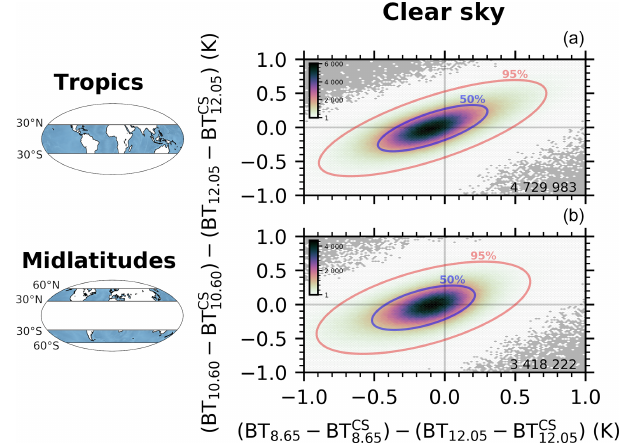
Figure 2. Clear-sky IIR signature (Sect. 3) observations over ocean during the 2008–2019 period shown as the difference between the 10.60 and 12.05µm channels ( y axis) as a function of the difference between the 8.65 and 12.05µm channels ( x axis). Panels (a) and (b) show the tropics (30 ◦ S–30 ◦ N) and the midlatitudes (30–60 ◦ ) regions. The 5km atmospheric columns are considered as clear-sky column when they do not contain any feature detected with hori- zontal averaging less than 80km (so no single-shot cleared cloud either). The color map of each 2-D distribution linearly increases from one (white) to the maximum (black) of each subplot; no oc- currence appears gray. The red and blue ellipses represent the 95% and 50% confidence intervals of the 2-D Gaussian PDF estimated from those observations. The total number of occurrences is given on the bottom-right corner of each